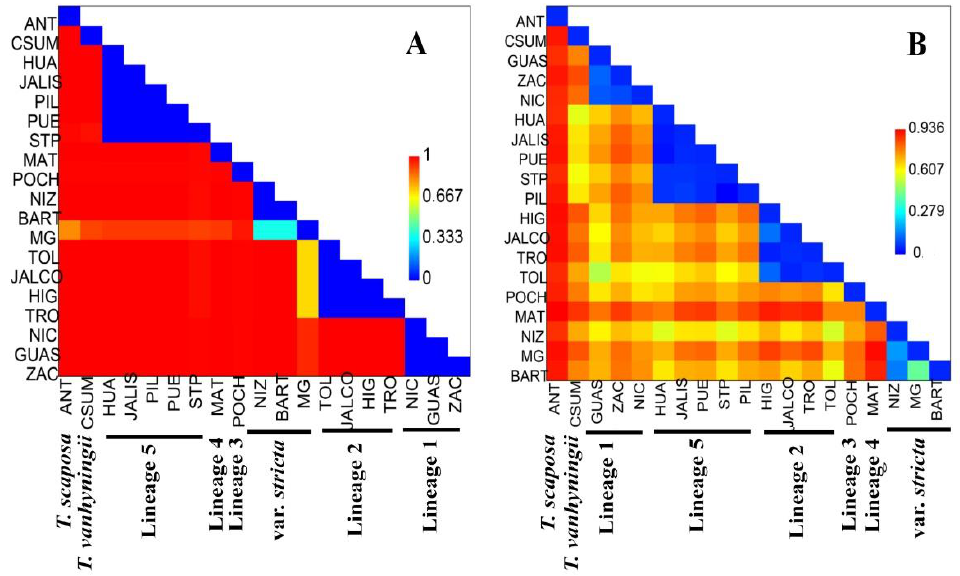
Figure 4. F ST values for pairwise comparison between populations of T. ionantha complex. ( A ) F ST pairwise of cpDNA and ( B ) F ST pairwise of pairwise of cpDNA and ( B ) F ST pairwise of nDNA.